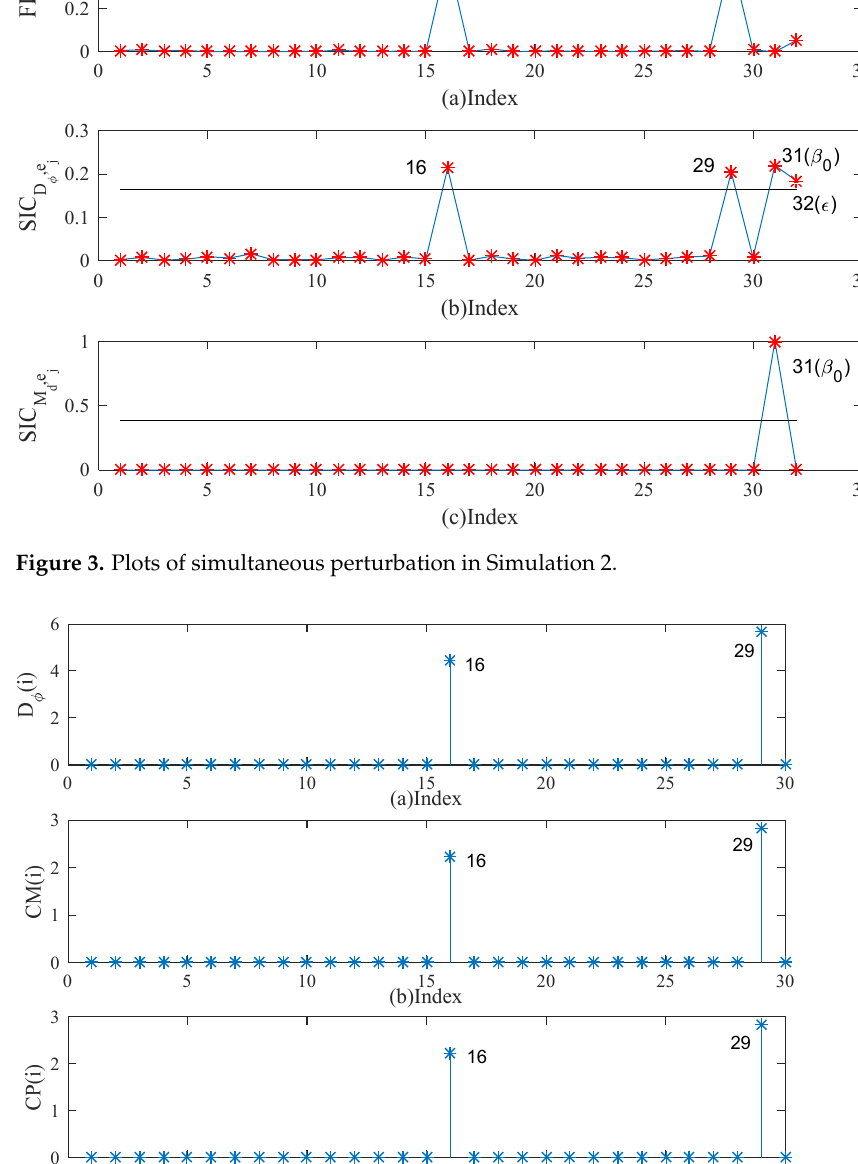
Figure 5. Diagnostic plots of response variables outliers in Simulation 3.